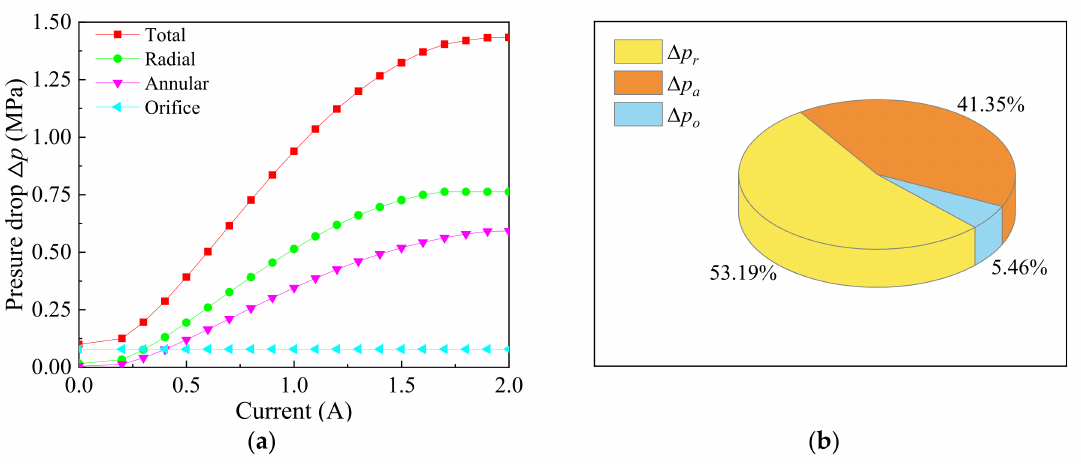
Figure 7. Estimation of simulated pressure drop of the proposed MR valve: ( a ) pressure drop variations from each region, ( b ) percentage of pressure drop from each region.